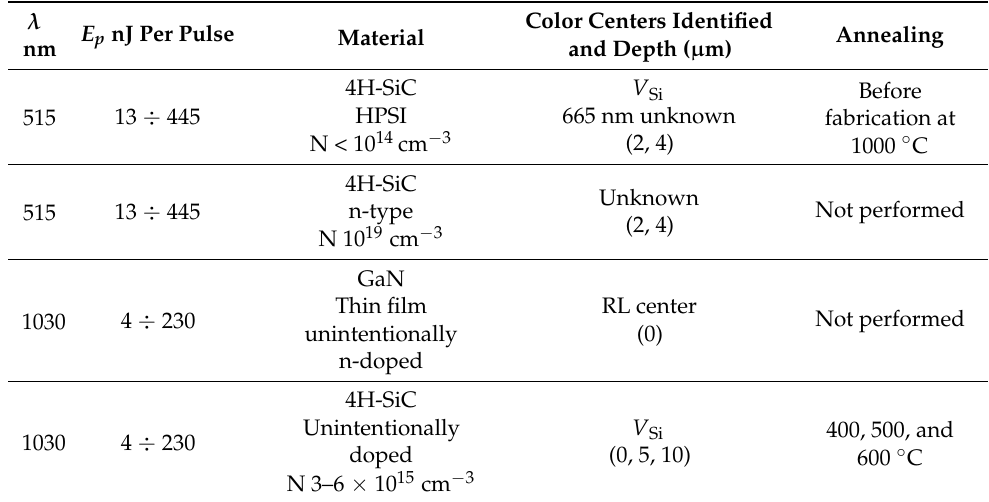
Table 1. Samples studied in this